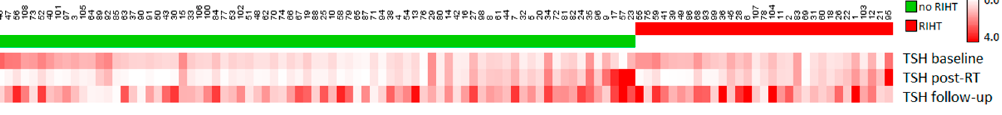
Figure 3. TSH levels in patients with and without follow-up RIHT (all patients with RIHT during hormone replacement therapy at follow-up). Abbreviations: TSH = thyroid stimulating hormone; RIHT = radiation-induced hypothyroidism.